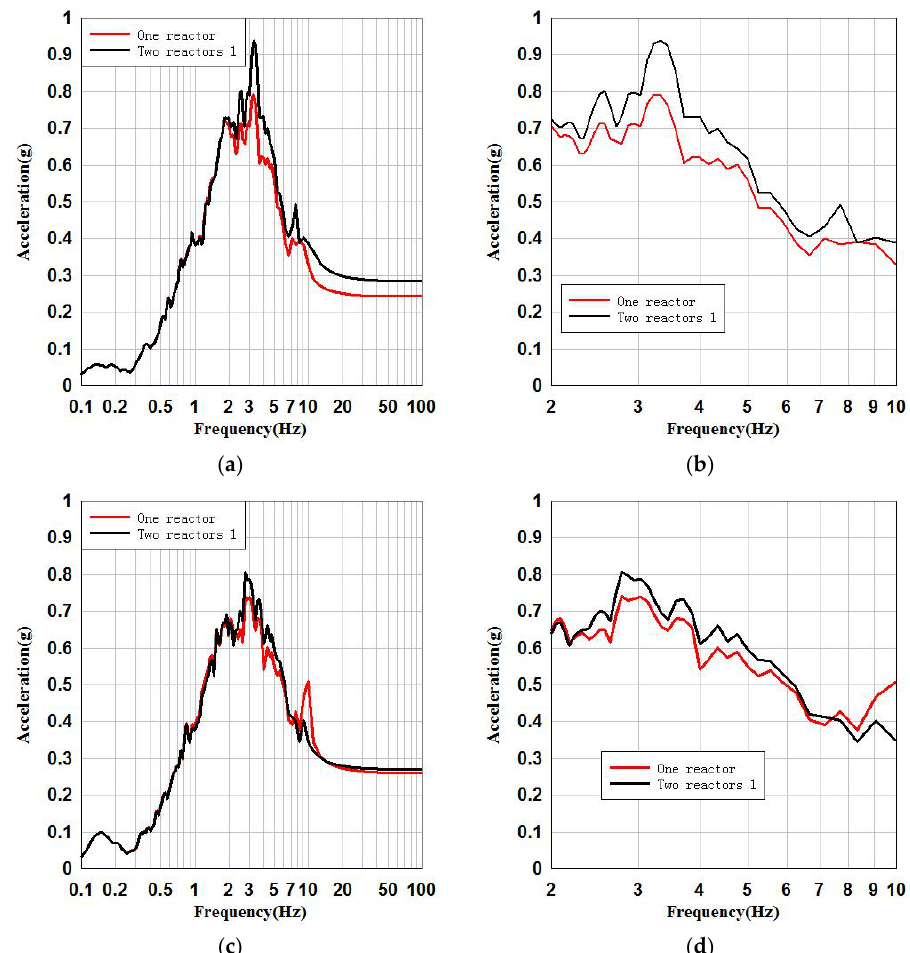
Figure 7. Comparison of FRS of raft foundation reference points in x and y directions between SSI system and SSSI system. ( a ) FRS of the raft foundation in the x direction. ( b ) FRS of the raft foundation in the x direction (2–10 Hz). ( c ) FRS of the raft foundation in the y direction. ( d ) FRS of the raft foundation in the y direction (2–10 Hz). Table 7. Peak acceleration of the raft foundation of SSI system and SSSI system.